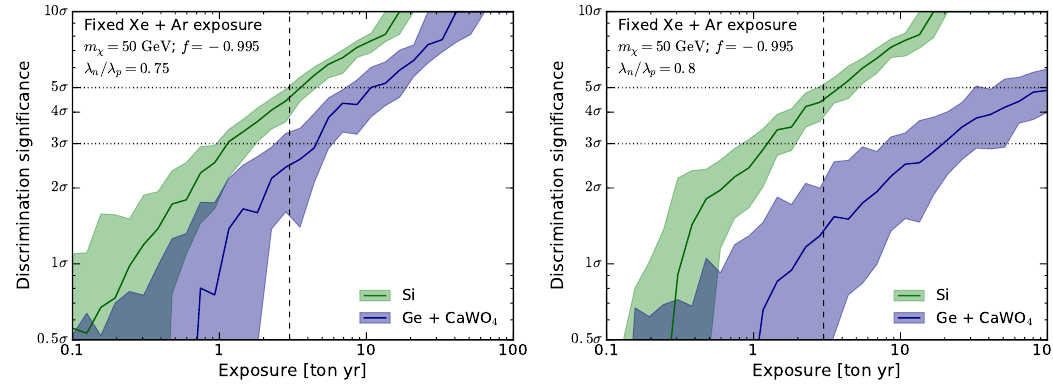
Figure 5 . Median signi(cid:12)cance for discriminating Dirac from Majorana DM as a function of ex- posure. Median and 68% band for the expected discrimination signi(cid:12)cance as a function of the exposure of either an Si (green) or combined Ge+CaWO 4 (blue) experiment. The exposures of the Xenon and Argon detectors are (cid:12)xed and given in table 1. For the Ge + CaWO 4 experiment, the total exposure is divided equally between Ge and CaWO 4 . Results are for a DM mass of 50 GeV and couplings of f = (cid:0) 0 : 995 and (cid:21) n =(cid:21) p = 0 : 75 (0 : 80) in the left (right) panel. These two parameter points are marked as red squares in the left panel of (cid:12)gure 4. The vertical dashed line corresponds to an exposure of 3 ton-years, which is the benchmark from table